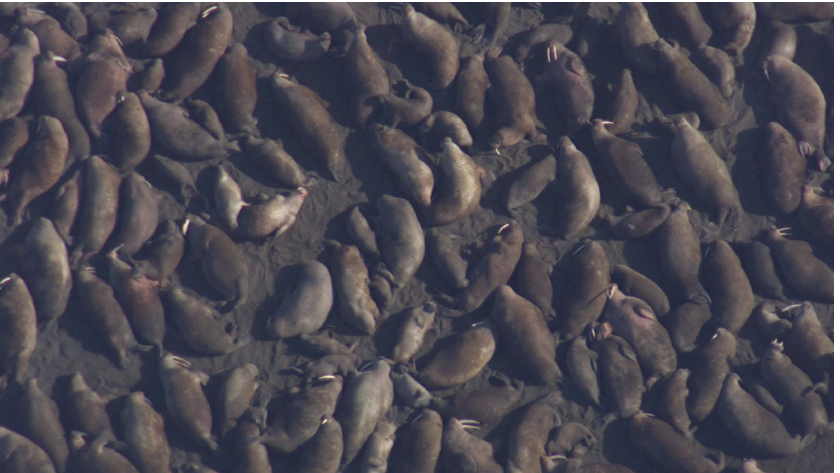
Figure 2. Example Cineflex image taken at an altitude of approximately 915 m. Image of Pacific walruses hauled out on the northwest coast of Alaska on 25 August 2011. Image is projected at 100%, though video and reference image resolution allowed tusk:snout measurements to be made at 400% or more digital zoom. Pixel size is , 0.9 cm.